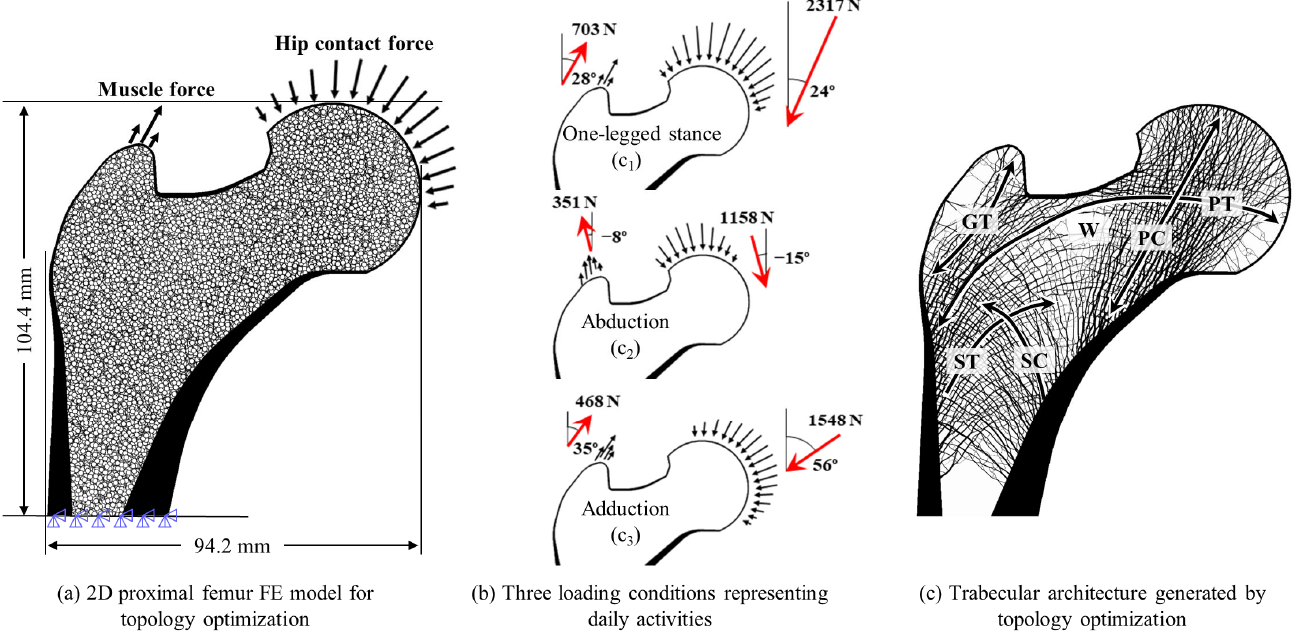
Figure 2. Generation of trabecular bone microstructure based on topology optimization. ( a ) Finite element model with the initial pattern of hollow circles, ( b ) three loading conditions: one-legged stance, abduction, and adduction, and ( c ) trabecular architecture generated by topology optimization.